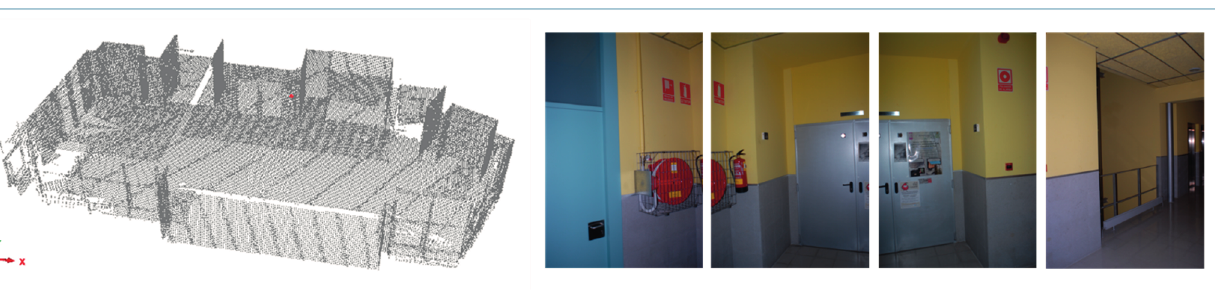
Figure 2. An example of a complete point cloud of an indoor scene and four images partially covering the horizontal field of